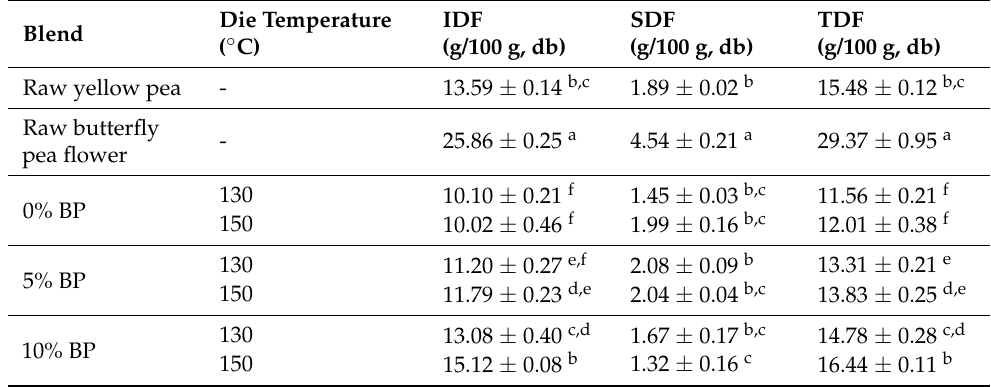
Table 1. Insoluble dietary fiber (IDF), soluble dietary fiber (SDF), and total dietary fiber (TDF) (mean ± standard deviation) of raw materials and extrudates as a function of extrusion die temper- ature and butterfly pea flower (BP) concentration. Values in the same column followed with same letters are not significantly ( p < 0.05) different ( n = 2 for dietary fiber